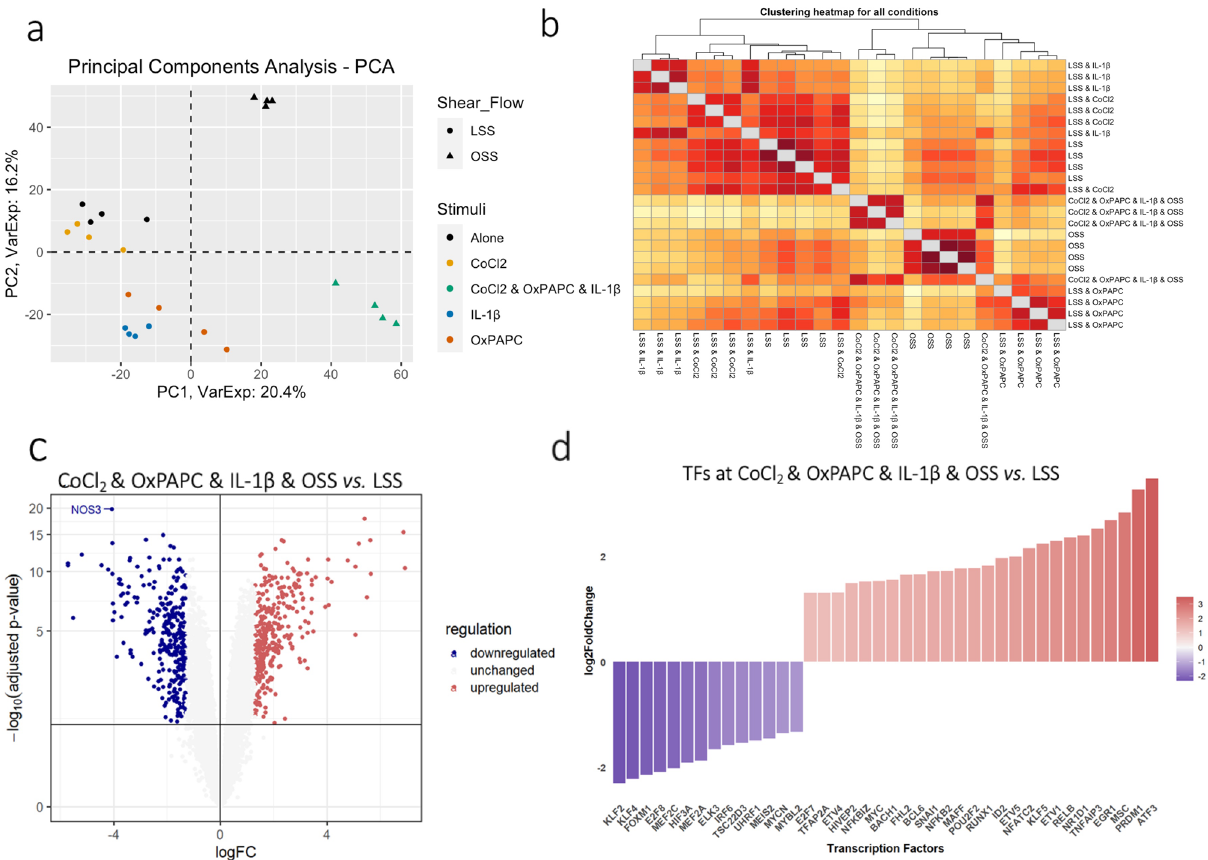
Figure 2. Gene expression profile revealed the hierarchical contribution of the CVD risk factors CoCl 2 , OxPAPC, IL-1β and OSS and key TFs relevant to endothelial function. ( a ) Principal Component Analysis (PCA) of gene expression profile from each sample showed that the PC1 explained 20.4% of the variation while PC2 16.2%. ( b ) Hierarchical clustering heatmap using Euclidean distance as a measured parameter revealed details of hierarchical contribution by each condition according to their distance to the LSS. ( c ) Volcano plot showed the differentially expressed genes (DEGs) when comparing the clustered risk factors vs. LSS. The DEGs were considered as adjusted p -value < 0.05 and |Log2foldchange|> 1.3. ( d ) TF identified among the DEGs and their respective log2 foldchange. Genes in blue are downregulated and in red are